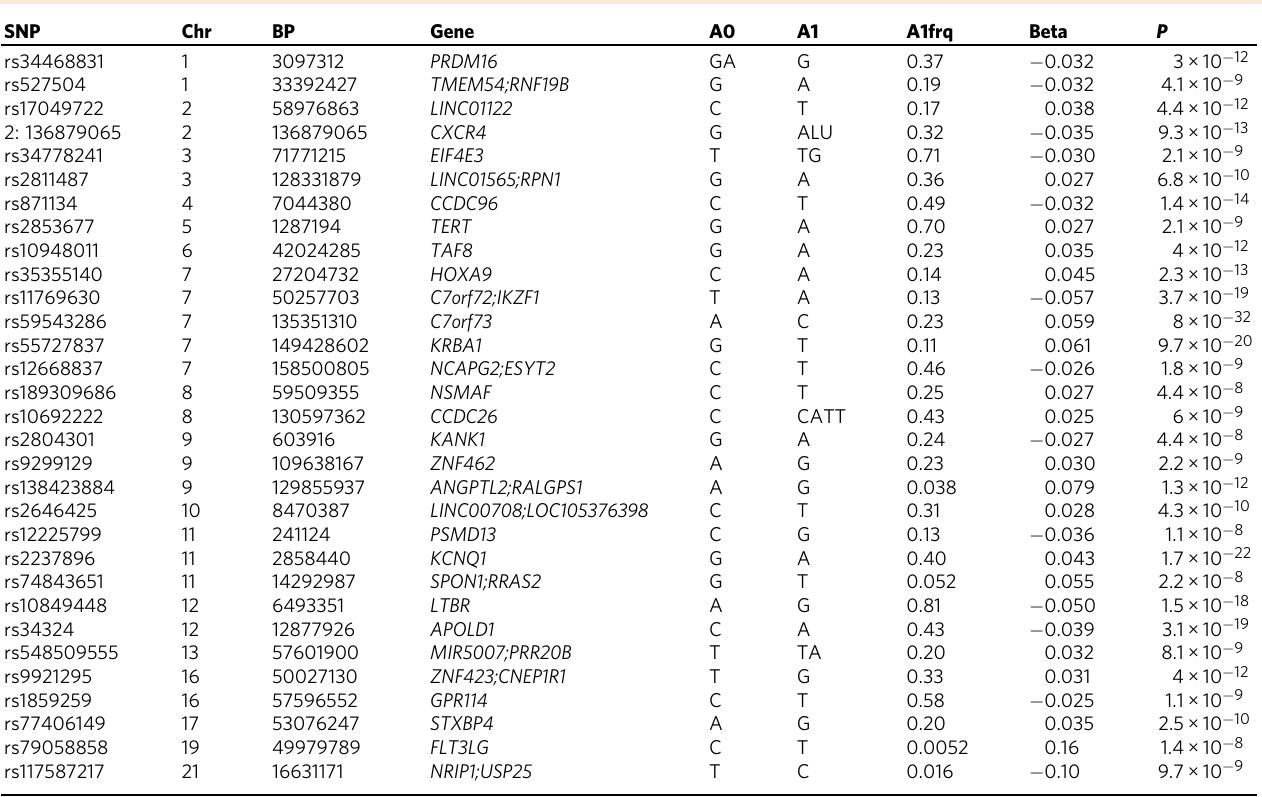
Table 1 A total of 31 previously unreported signi fi cant loci in